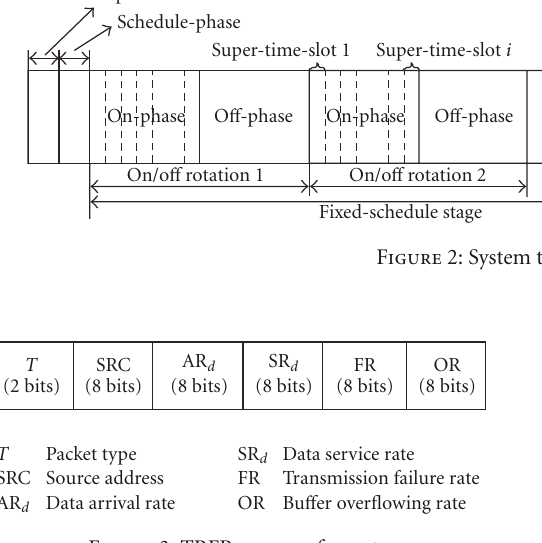
Figure 3: TRFR message format.